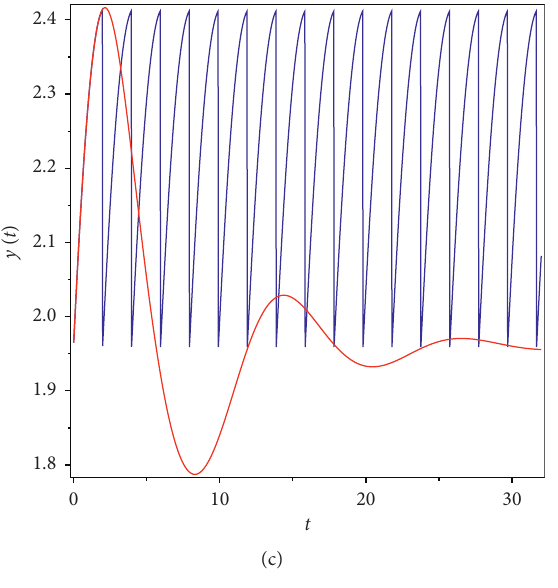
( y ) > y M A A . And the parameters are fixed as